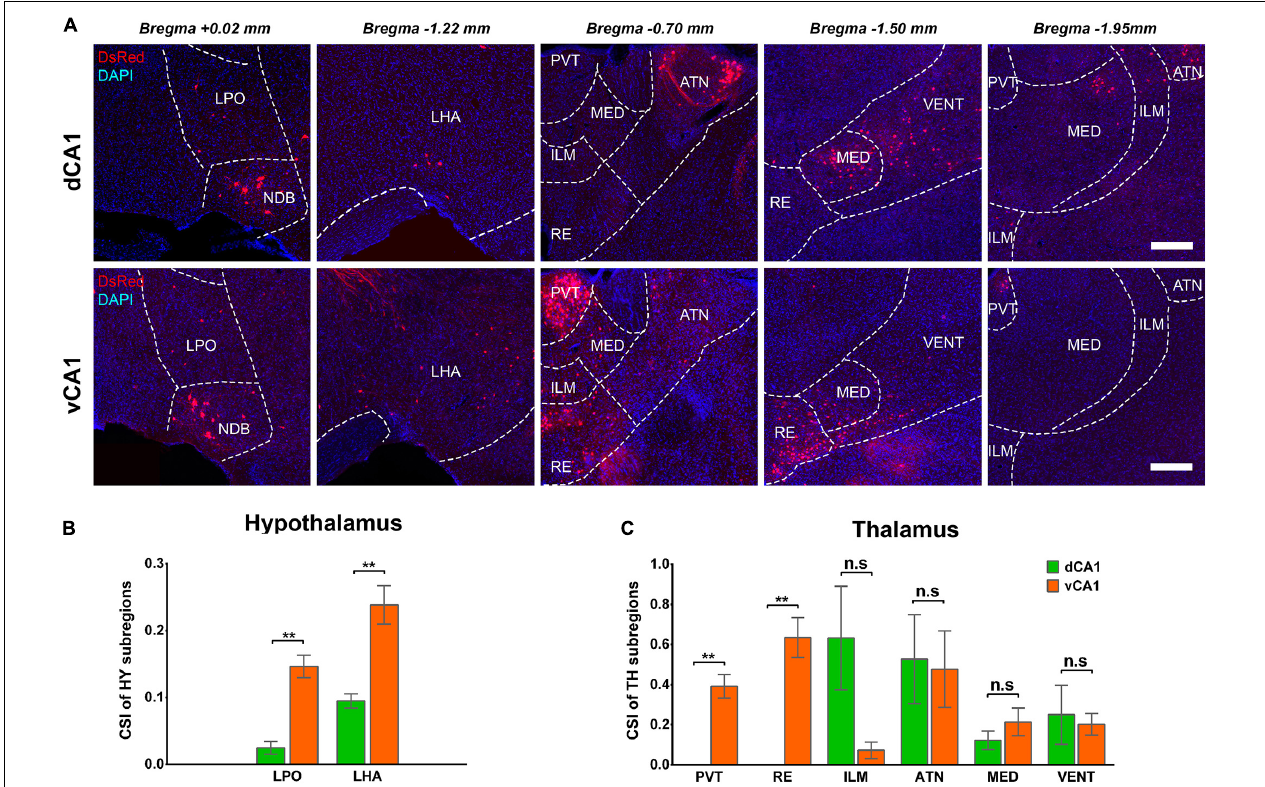
FIGURE 8 | Distribution patterns of HY and TH inputs between the two CA1 tracing groups. (A) Representative images showing inputs from the selected subregions of HY and TH to the dCA1 or vCA1 PNs. Scale bar: 250 µ m. (B) CSI of the inputs in HY subregions. (C) CSI of the inputs in TH subregions. n.s., no significant difference; ** P <